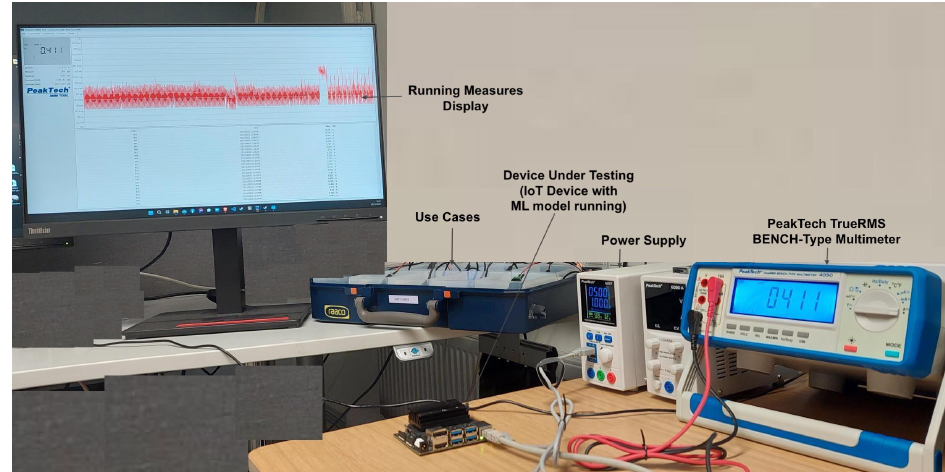
Figure 5. Hardware setup for the measurement of power and current consumption.